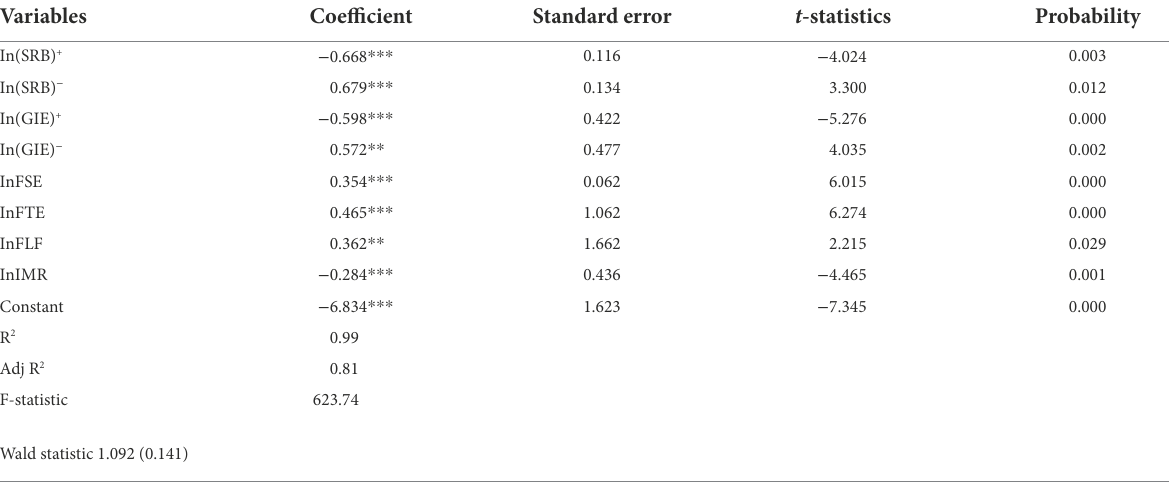
TABLE 5 NARDL long-term variable elasticities results (Dependent variable: GDP).